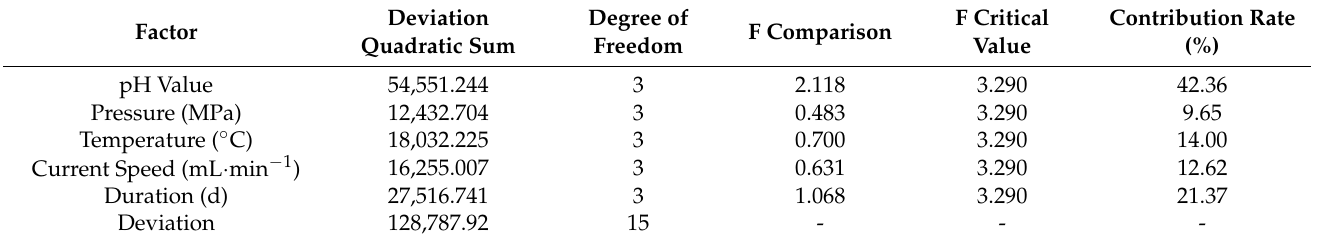
Table 7. Variance analysis of dissolution rate of the specimen ( mg · g – 1 ).